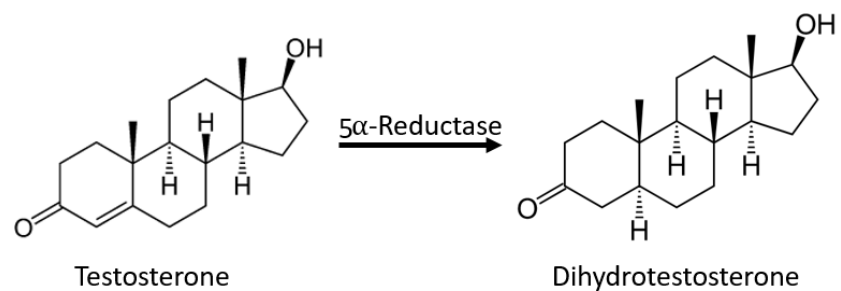
Figure 8. Reduction of testosterone to dihydrotestosterone.